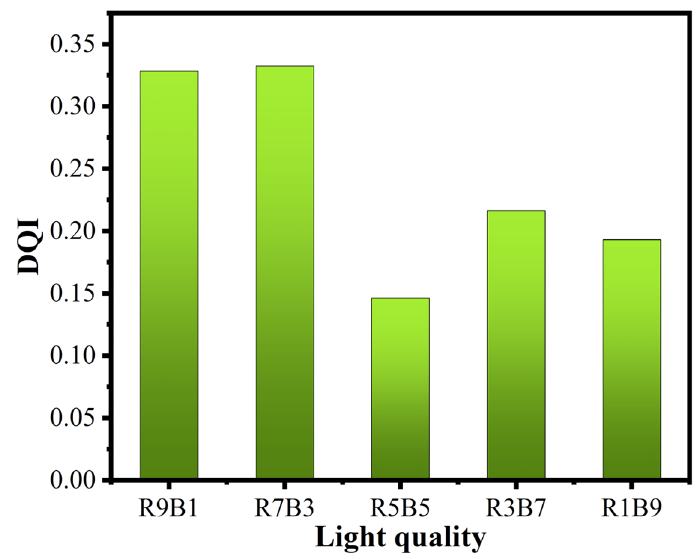
Figure 5. DQIs of cucumbers under different light qualities.